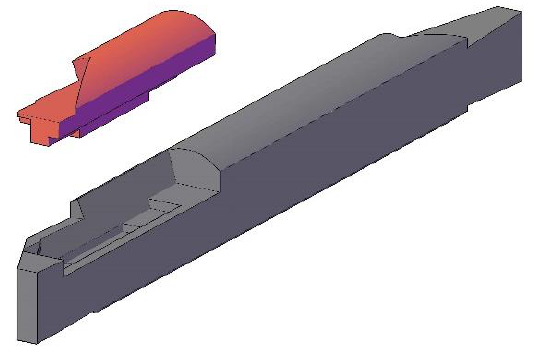
Figure 30. A 3D model beam (I2) drawing of the structural repair of the damaged beam.